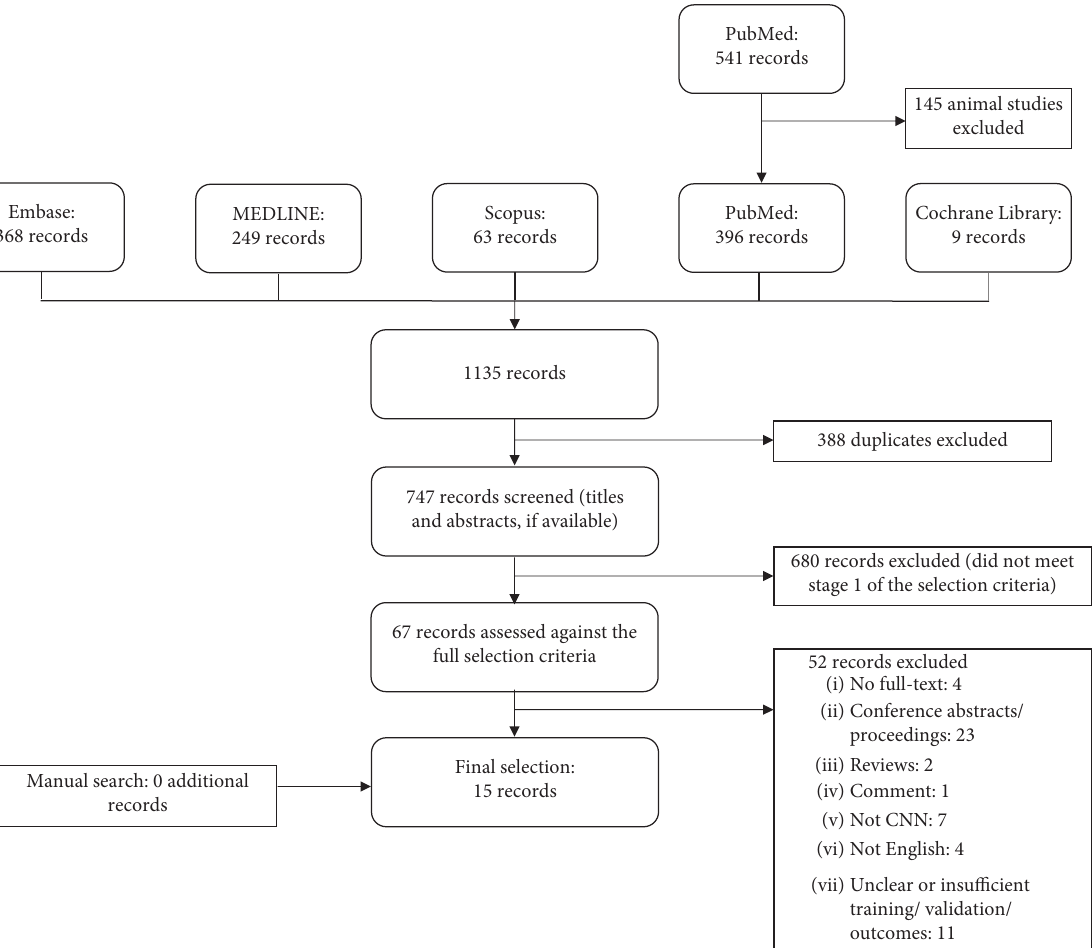
Figure 1: Flowchart of the study selection process. CNN � convolutional neural